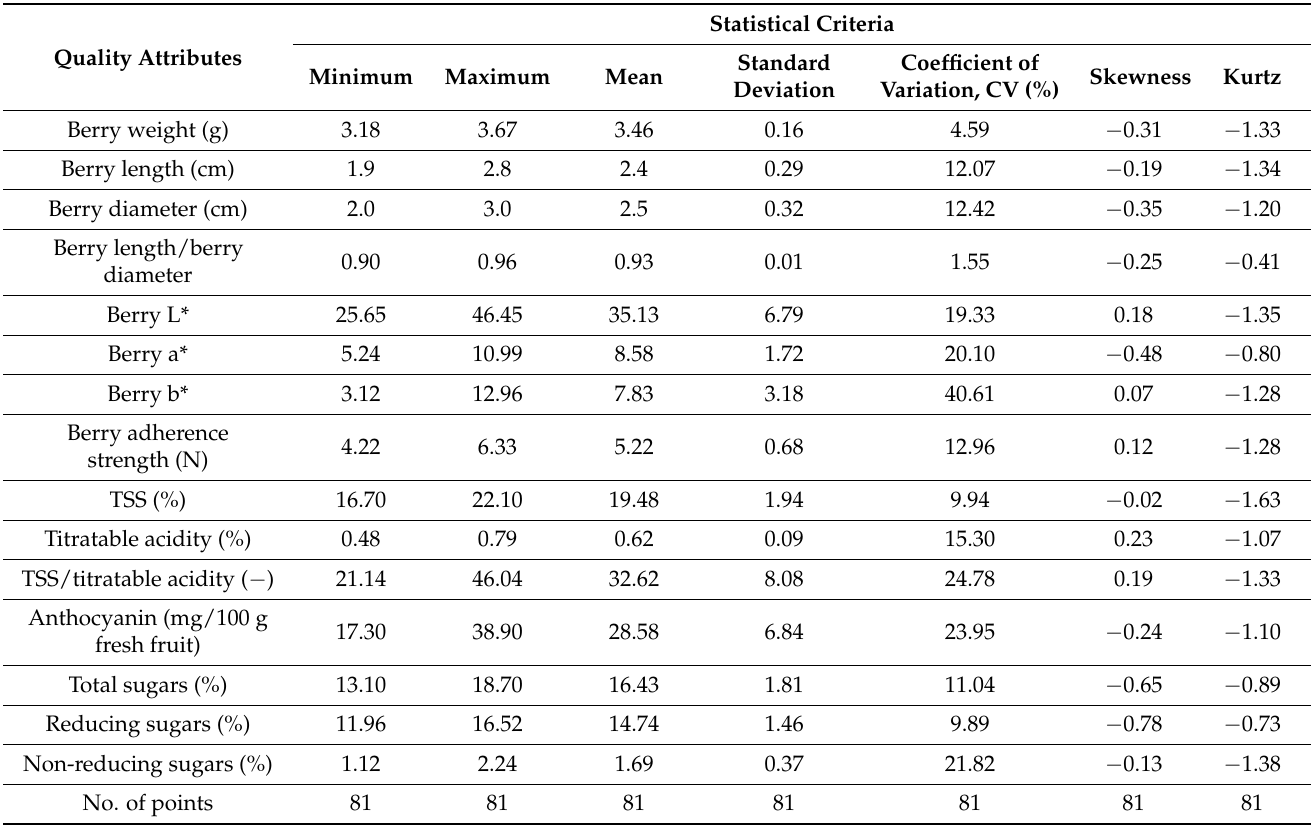
Table 1. Statistical criteria of experimental results of quality attributes of Flame Seedless grape berries cultivated under various agronomical management and other